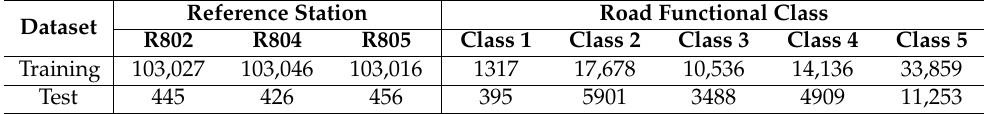
Table 2. The number of NO 2 measurements in training set and test set for each validation